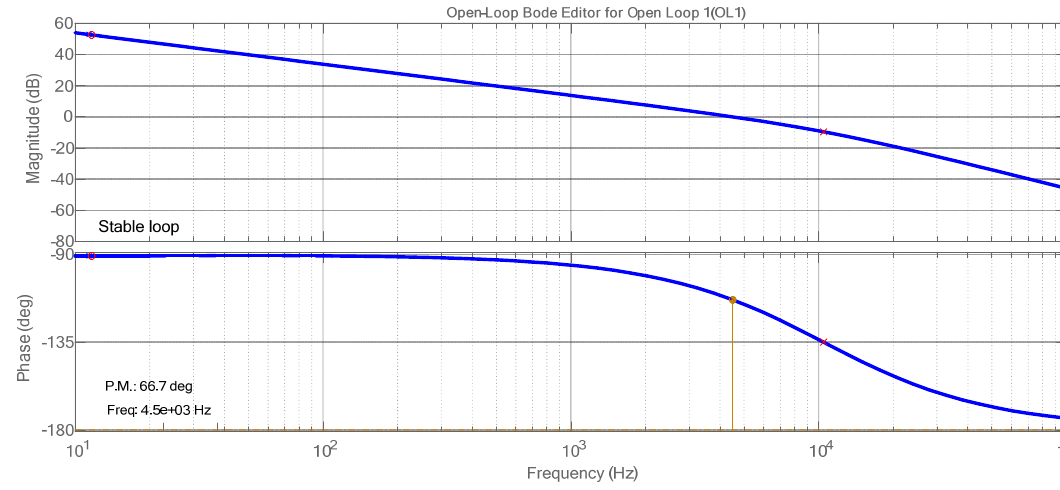
Table 2. Main active power filter (APF) parameters.